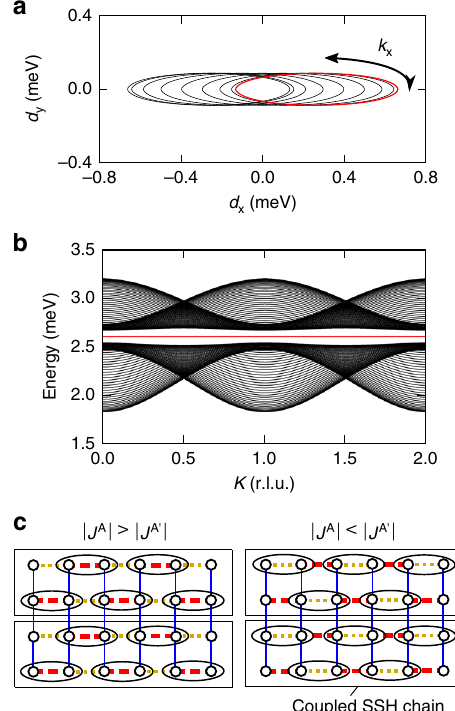
Fig. 5 Schematic view of expected pseudomagnetic fi eld and edge states. a Distribution of a pseudomagnetic fi eld induced on the triplon bands. Each solid curve represents a pseudomagnetic fi eld with a fi xed k y (see Eq. (5) for its de fi nition). b Energy spectrum along the K direction. The calculation is based on the model presented in Fig. 1b, in which open boundary conditions with 200 sites (100 for each sublattice) are imposed along the a direction while periodic boundary conditions are set along the b direction. Half of the all modes are shown, and edge states are stressed by a red line for clarity. c The interdimer network in Ba 2 CuSi 2 O 6 Cl 2 shown as SSH chains coupled by interchain hoppings. The same symbols and lines as those in Fig. 1 are used. An ellipsoid and a dashed rectangle represent a pair of dimers with a larger hopping amplitudes and a single coupled SSH chain,